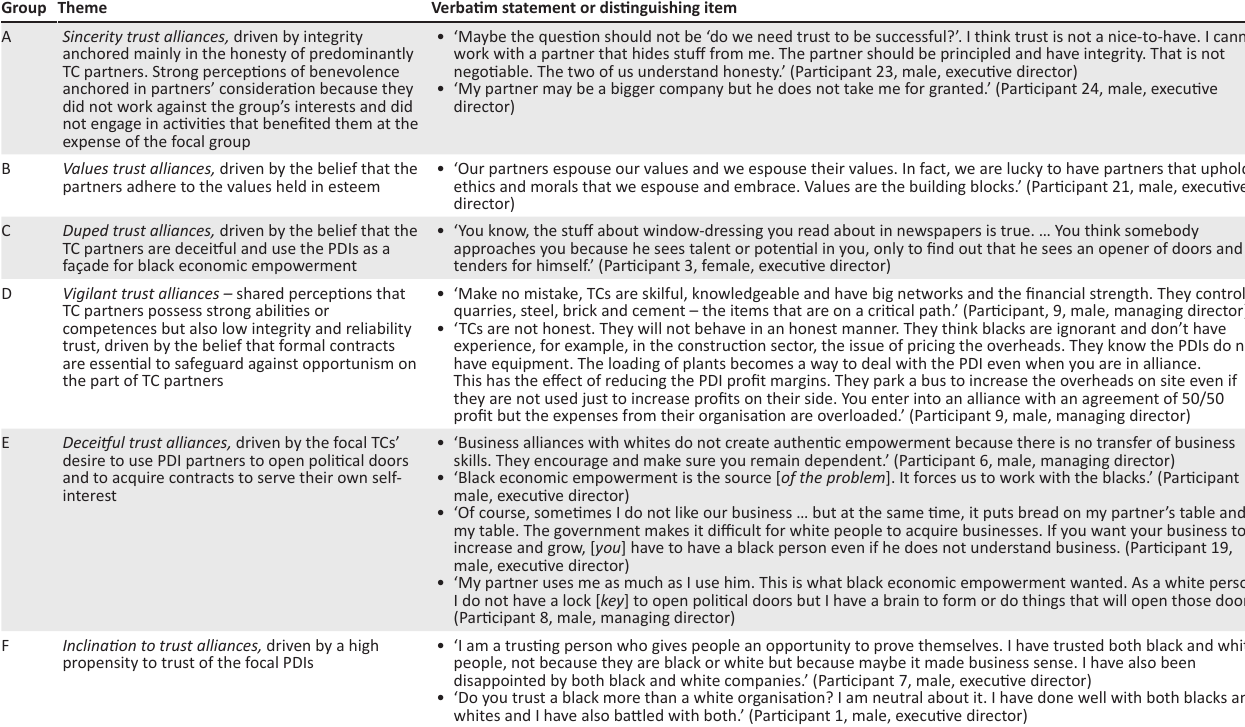
TABLE 2: Clusters of trust. Group